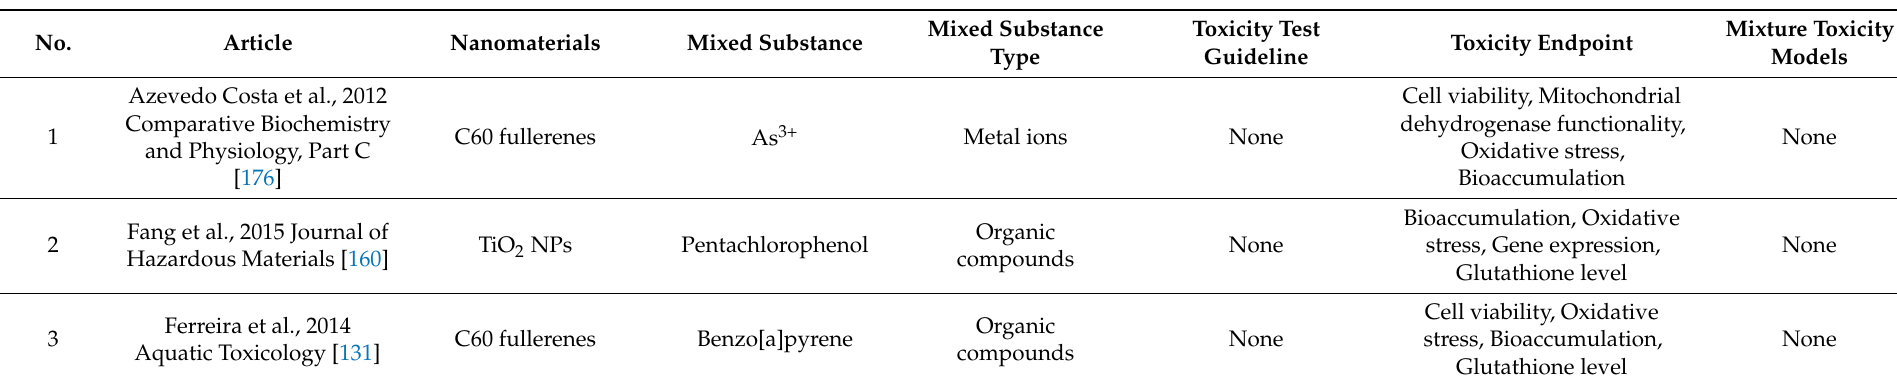
Table 3. Summary of current nano-mixture toxicity data for D. rerio